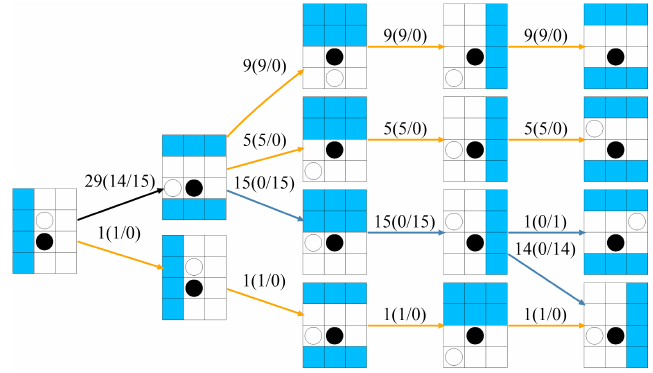
Figure 8. State transitions for Subject 7 starting from an adjacent state.